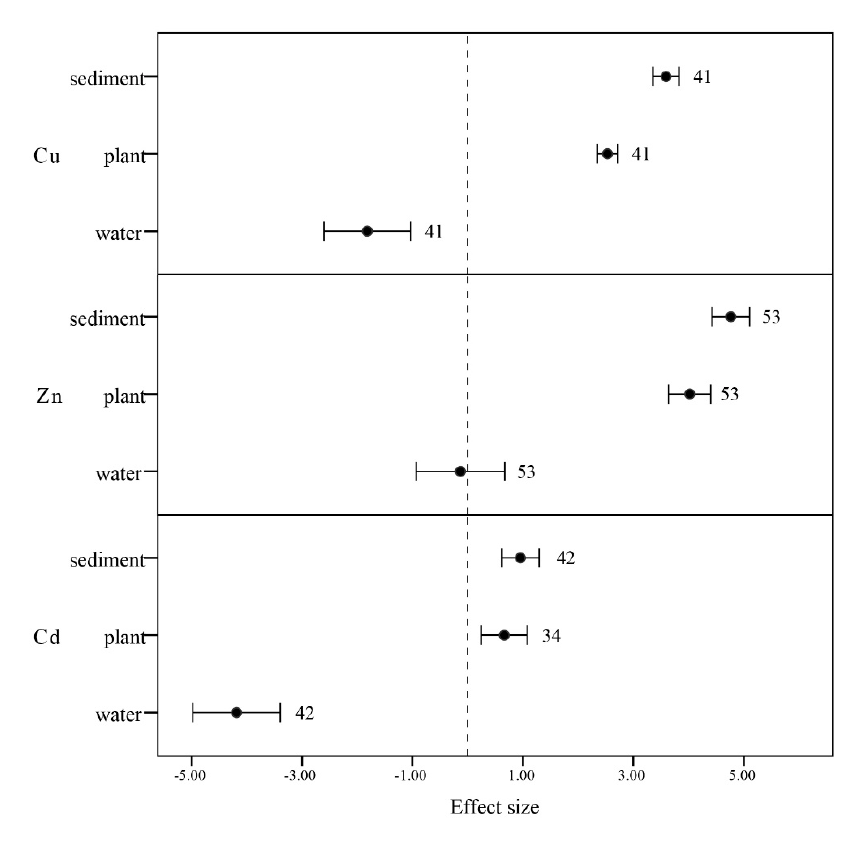
Figure 6. Mean BCF values of concentration on aquatic plants, water, and sediments categorized by Zn, Cu, and Cd. Error bars represent 95% bootstrapped confidence intervals (CIs). The effect of heavy metal concentration ability in aquatic plants was considered significant if the 95% CI of the effect size did not overlap with zero. The number of observations for each category is shown next to the error bars.